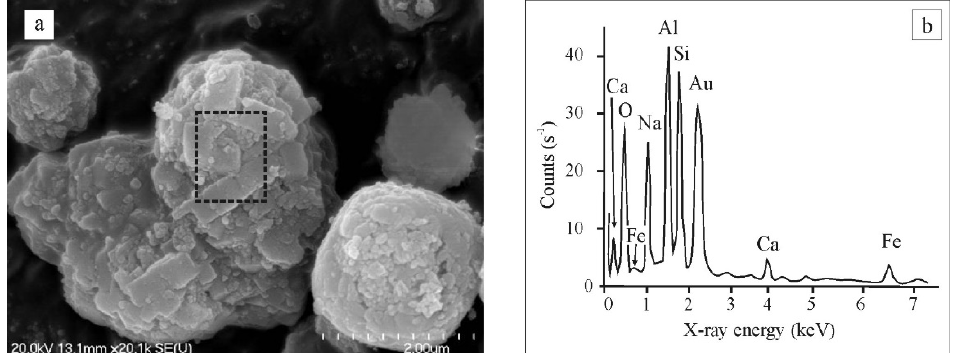
Figure 3. Cancrinite-goethite aggregates of the studied red mud. ( a ) SEM microphoto of an aggregate grain. The rectangle shows the area measured with EDS. ( b ) Typical EDS spectrum of the aggregate.